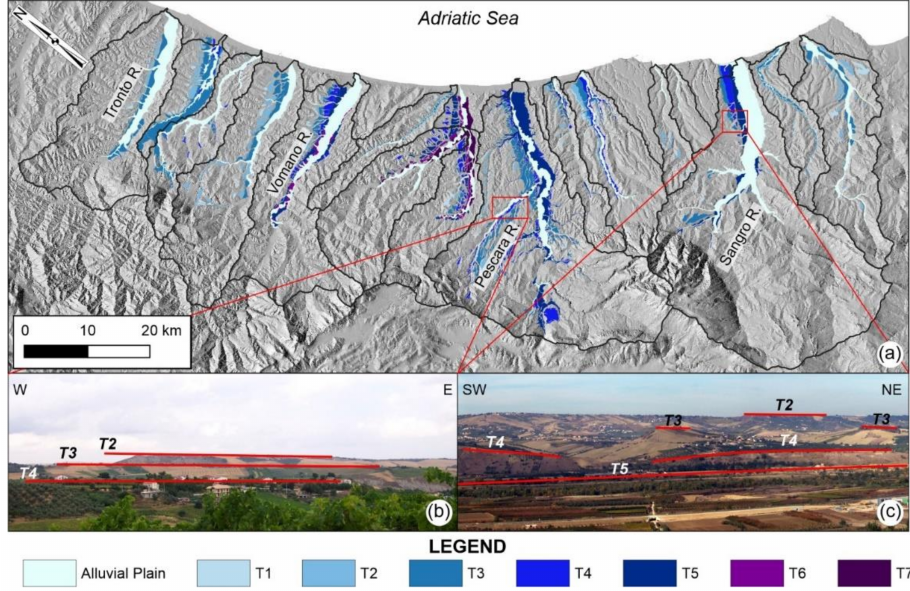
Figure 8. ( a ) Fluvial terraces scheme over the Abruzzo Periadriatic Area. The order of the river terraces was defined individually for each basin. Black lines represent the watershed of the main 16 basins analyzed. ( b ) Panoramic view of the distribution of the fluvial terraces near the confluence between Cigno and Pescara rivers. ( c ) Panoramic view of the distribution of the fluvial terraces in the lower reach of the Sangro